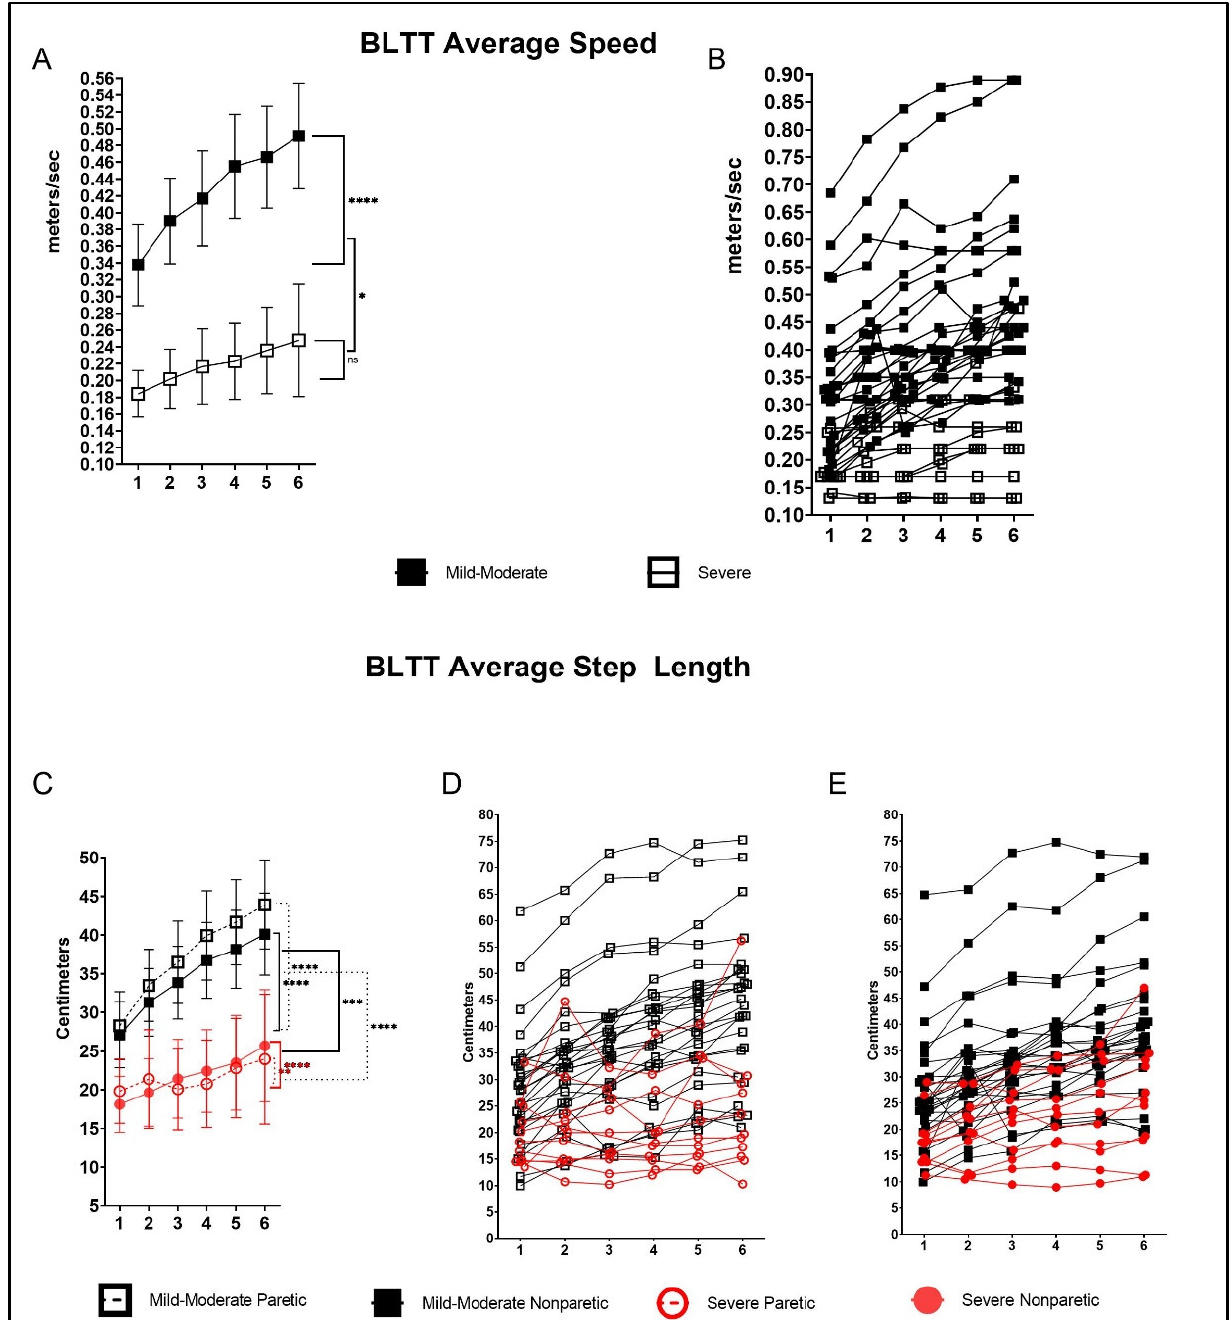
Figure 2. Backward locomotor training (BLTT) speed and step length over six training sessions. Mean progression in BLTT speed per training session from baseline session 1 (D2) through 6 (D7 ( A ); and individual values ( B ) paretic and nonparetic step lengths ( C ); and individual values; paretic ( D ), and nonparetic step lengths ( E ). Error bars show 95% CI; * p < 0.05, ** p < 0.01, *** p < 0.001, **** p < 0.0001.